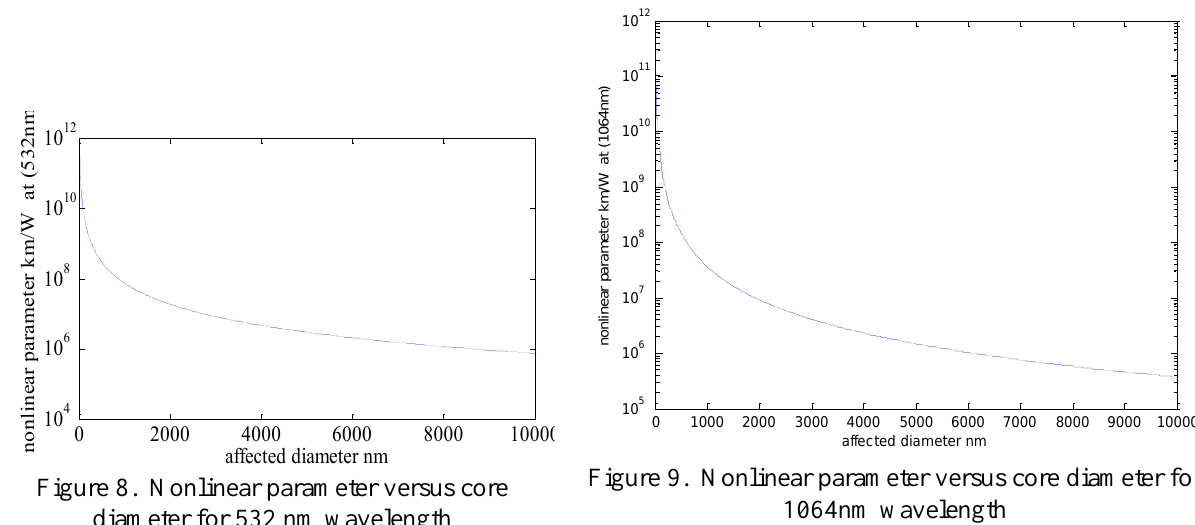
Figure 8. Nonlinear parameter versus core diameter for 532 nm wavelength